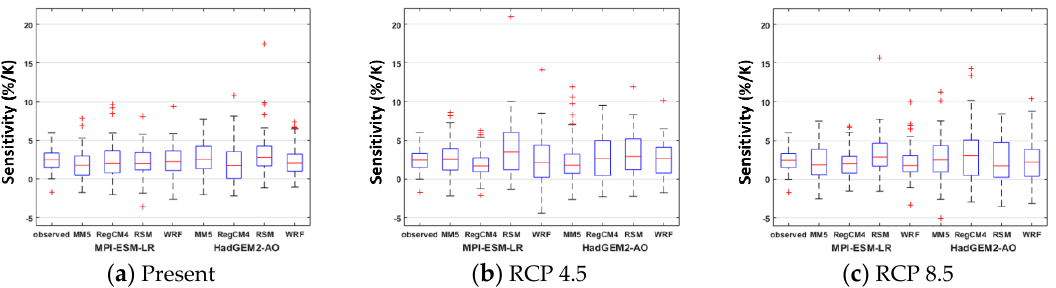
Figure 14. Sensitivity of annual exceedance daily rainfall depth to SAT.